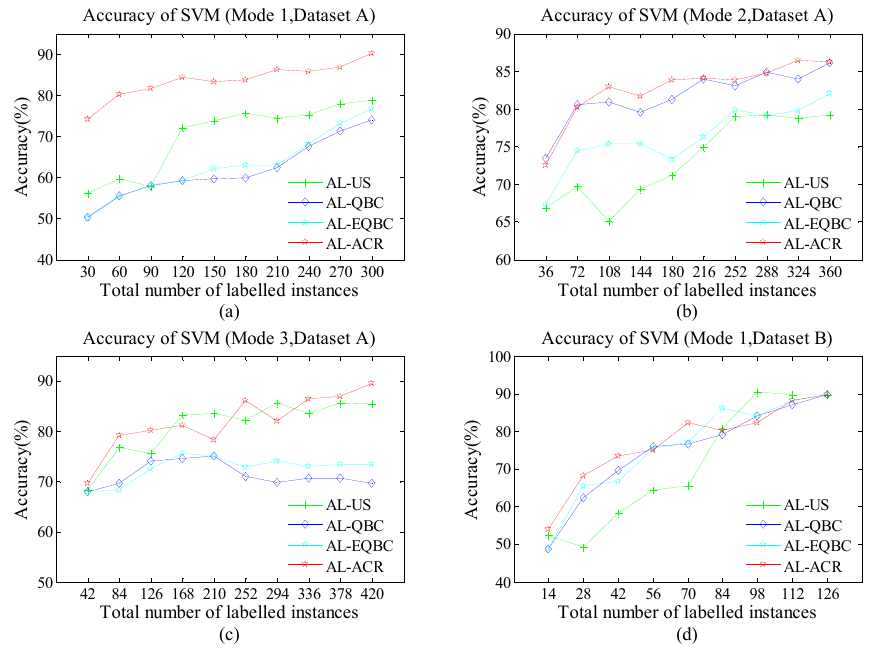
Figure 5. ( a ) Accuracy of support vector machine (SVM) (Scenario 1); ( b ) Accuracy of SVM (Scenario 2); ( c ) Accuracy of SVM (Scenario 3); ( d ) Accuracy of SVM (Scenario 4).